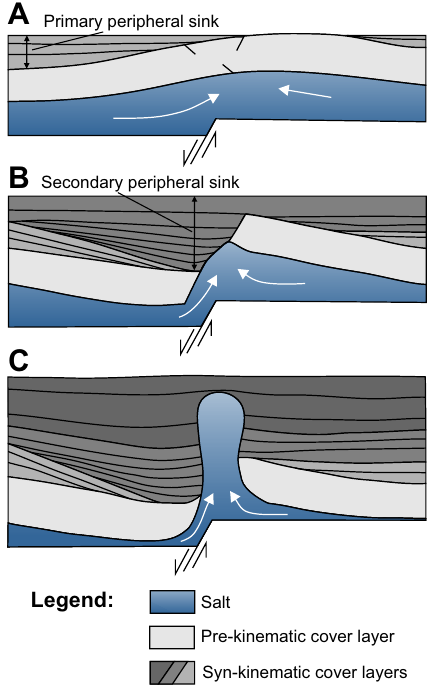
Figure 1. Conceptual model showing the evolution of a salt di- apir induced by basement faulting: (a) due to sedimentary loading a salt pillow develops prior to diapiric piercing, (b) further base- ment extension leads to faulting of the overburden and (c) reactive diapirism. Salt flow is governed by vertical displacement of the salt layer (elevation head) and differential loading due to sediment ac- cumulation in subsiding areas (modified after Koyi et al.,